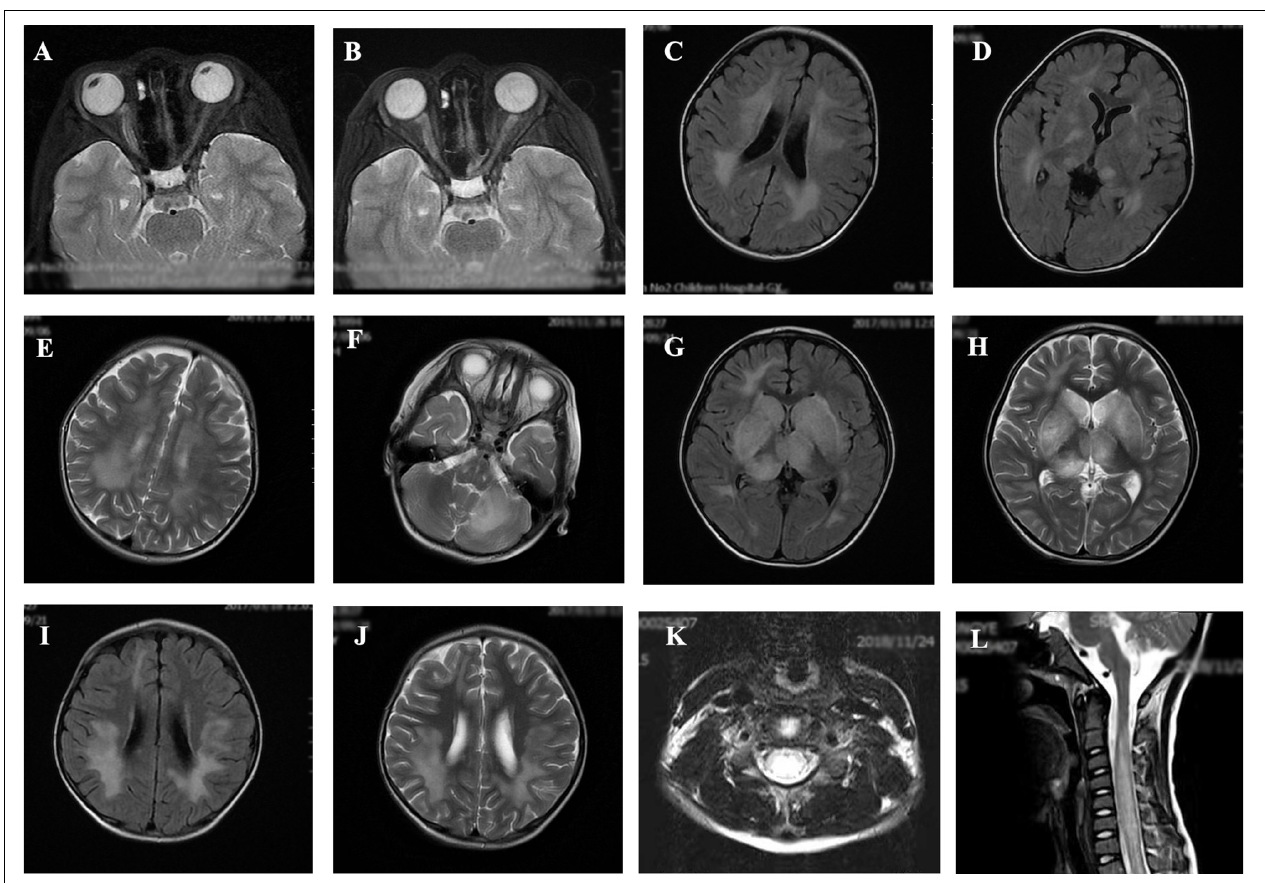
FIGURE 2 | Magnetic resonance imaging (MRI) results of acute disseminated encephalomyelitis (ADEM) children with or without myelin oligodendrocyte glycoprotein-immunoglobulin G (MOG-IgG. (A,B) (T2-axial) cerebral MRI of a 7-year-old boy with MOG-IgG seropositive ADEM showed small and blurred lesions of optical nerve. (C–F) [T2-axial, fluid-attenuated inversion recovery (FLAIR)-axial] cerebral MRI of a 2-year-old girl with MOG-IgG showed large, blurred lesions in bilateral white matter areas of frontal, parietal, and temporal lobes, bilateral basal ganglia, bilateral thalamus, and left cerebellar hemisphere. (G,H) (T2-axial, FLAIR-axial) cerebral MRI of a 4-year-old boy without MOG-IgG revealed a lesion in bilateral basal ganglia, thalamus, periventricular white matter, and right frontal lobe. (I,J) (T2-axial, FLAIR-axial) cerebral MRI of a 4-year-old girl with MOG-IgG seronegative ADEM showed large and blurred lesions in bilateral white matter areas of the frontal parietal. (K,L) (Sagittal-T2) Spinal MRI of a 2-year-old girl with MOG-IgG revealed prominent involvement of cervical and thoracic spinal lesion ( ≥ 3